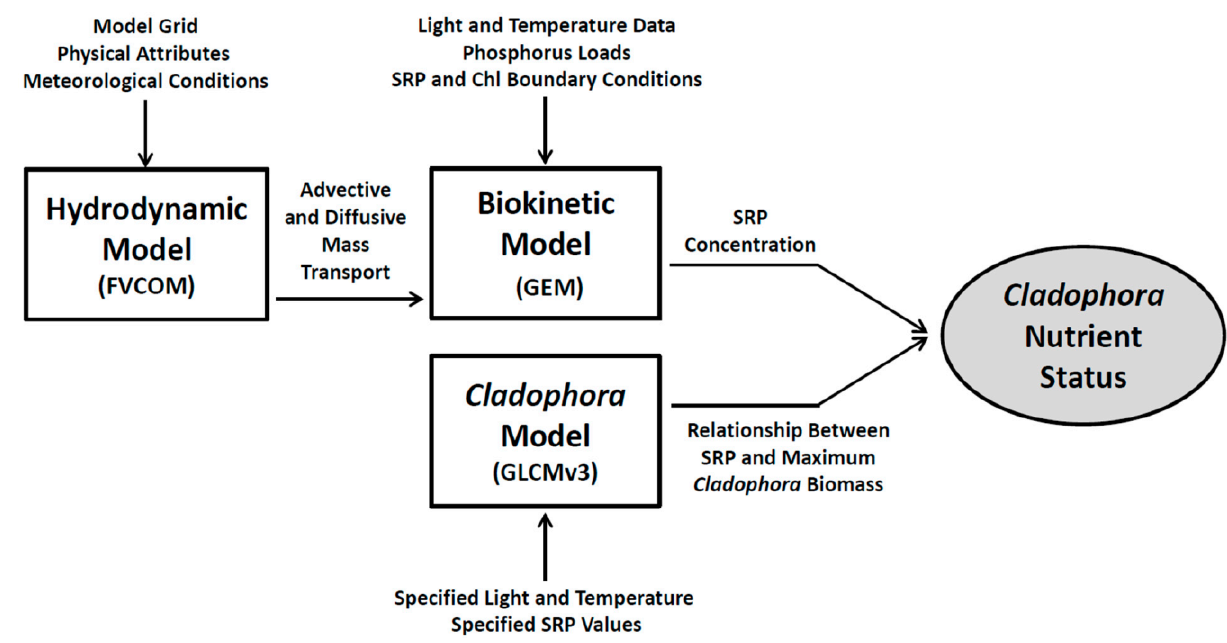
Figure 3. The modeling platform utilized in this work illustrating the three component modules (hydrodynamics, biokinetics and Cladophora nutritional status) and their inputs, outputs and